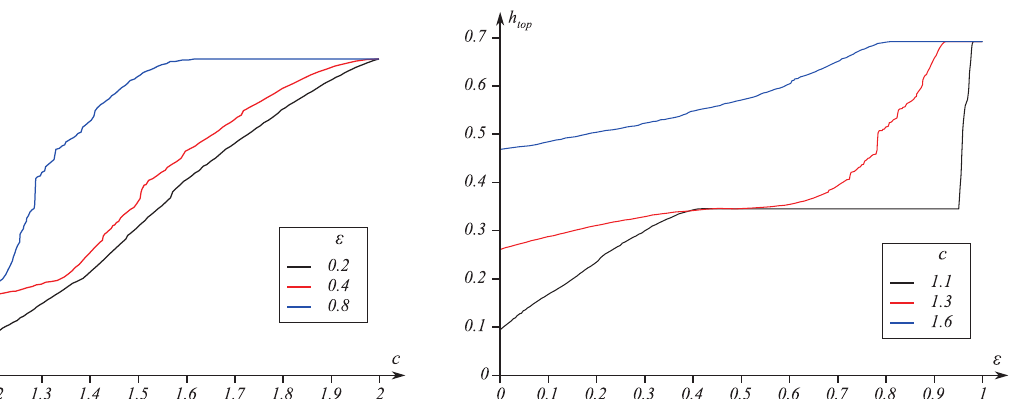
Fig. 11 The graph of topological entropy with respect to parameter c